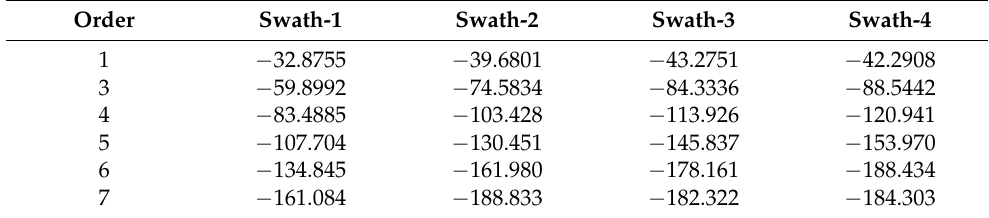
Table 3. The average NEL for four sub-swaths.